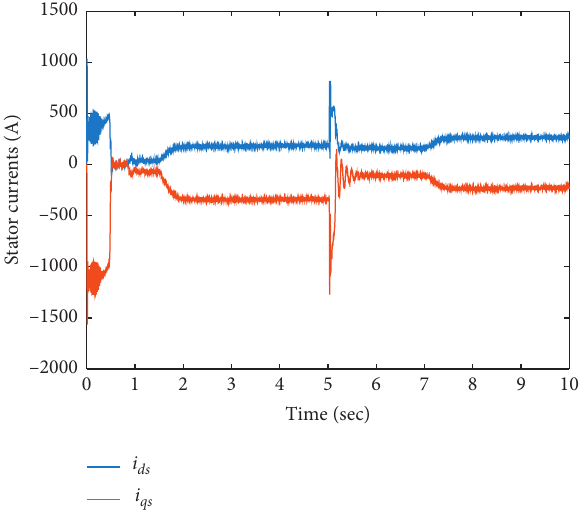
Figure 16: Time profiles of stator Table 1: Performance criteria results.